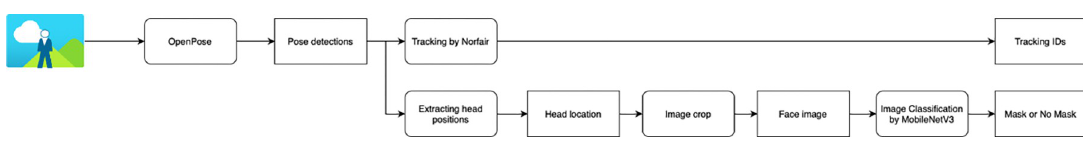
Fig 1. An end-to-end flowchart of the AiMask model.